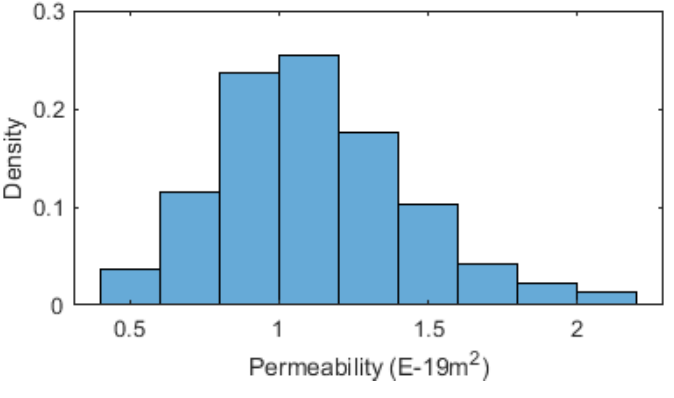
Figure 17. Spatial distribution of permeability within the cuboidal sample of Lac du Bonnet granite. ( Lower surface permeability records).